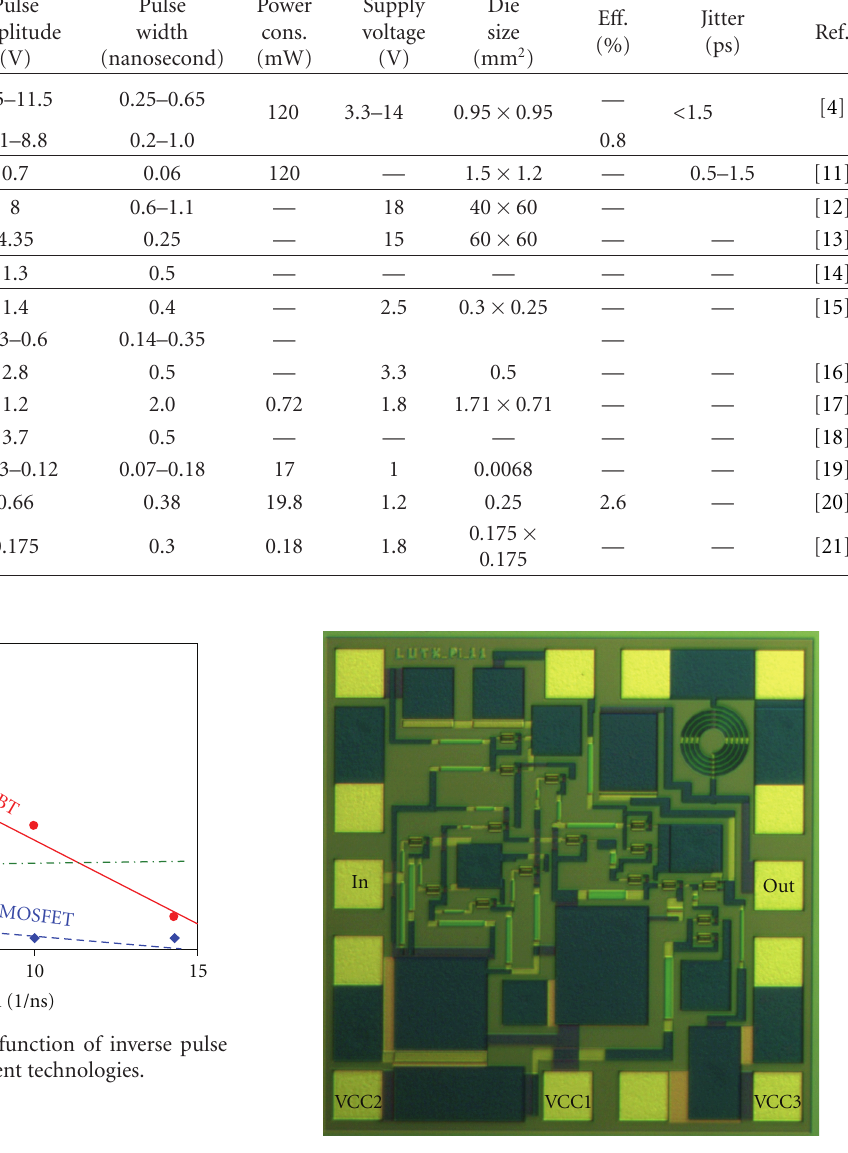
Figure 2: Micrograph of the ∼ 1 mm 2 GaAs HBT IC pulse